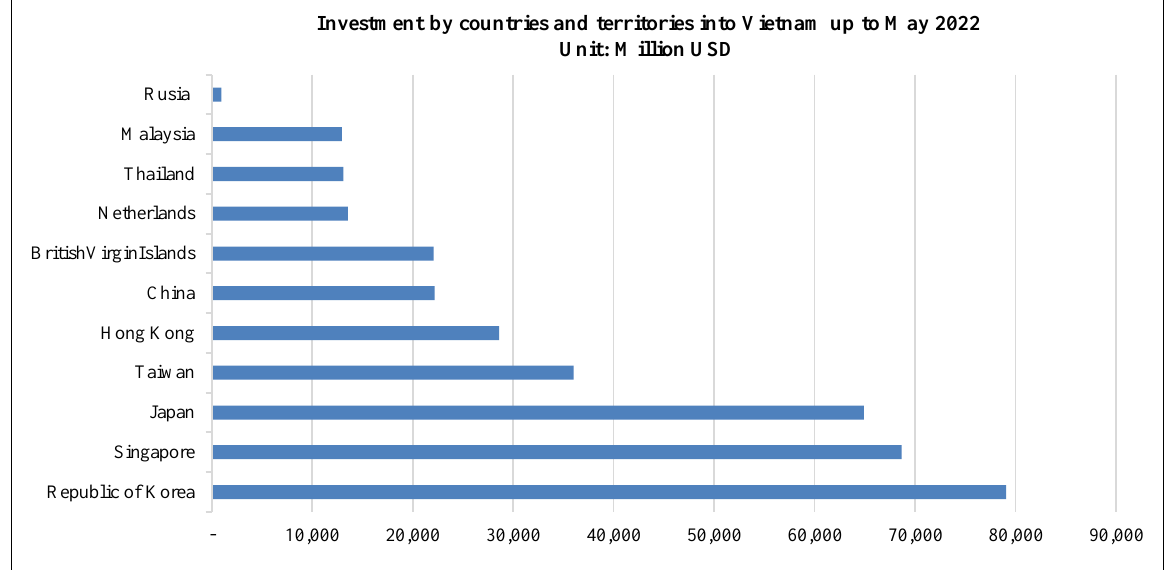
Figure 4. Investment by countries and territories into Vietnam up to May 2022 (Unit: Million